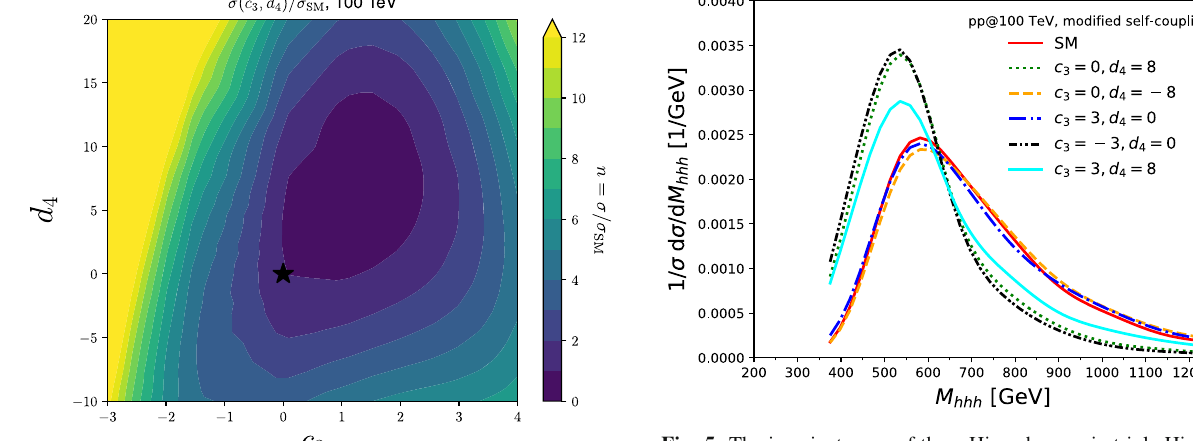
Fig. 5 The invariant mass of three Higgs bosons in triple Higgs pro- duction in the SM and with modified self-couplings ( λ 4 = λ SM ( 1 + d 4 ) and λ 3 = λ SM ( 1 + c 3 ) ) at the FCC-hh at 100 TeV, reconstructed from Monte Carlo truth with no cuts